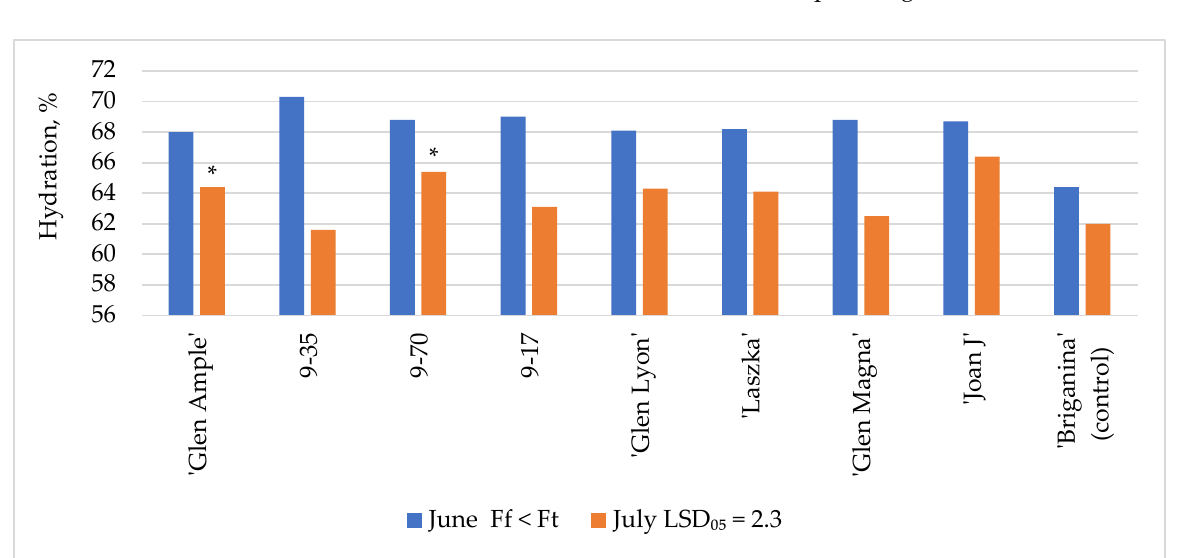
Figure 2. Hydration of raspberry leaf apparatus, % (2019–2021). *—significant differences at the 5% significance level.